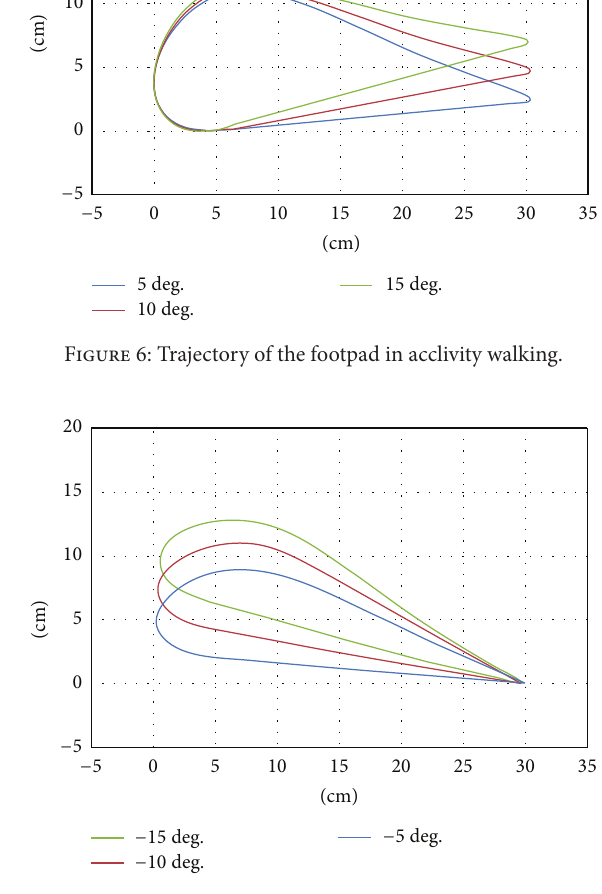
Figure 7: Trajectory of the footpad in declivity walking.